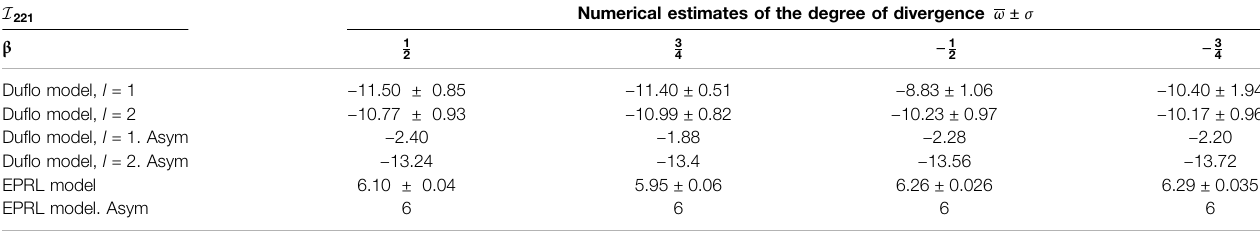
TABLE 3 | Summary of the estimated scaling exponent ω for leading order melonic graph G 221 . The EPRL values we found are in excellent agreement with other analytical results already available in the literature